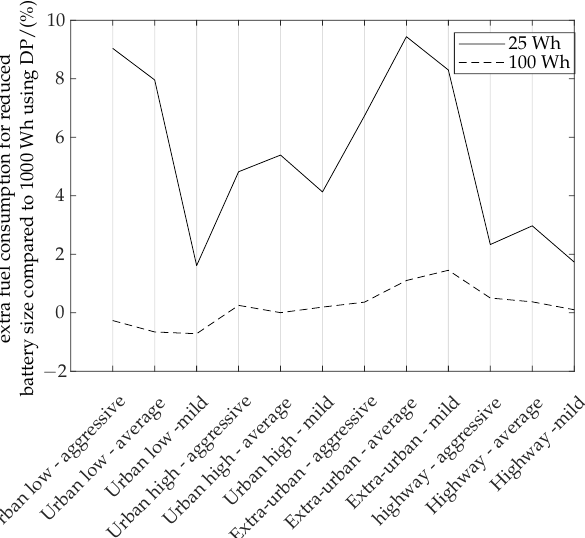
Figure 5. Using DP to analyze the global optimum (fuel consumption) for different battery capacities: extra fuel consumption when reducing the battery capacity to 25 Wh and 100 Wh compared to 1000